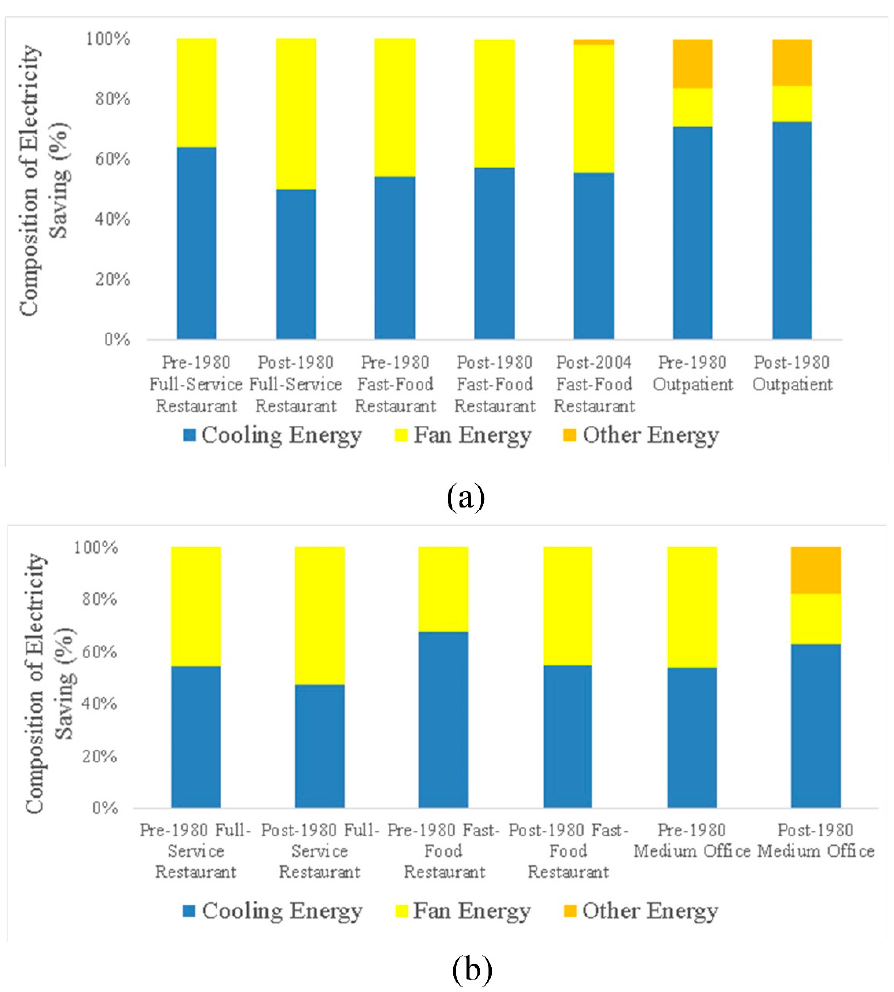
Figure 5. Percentage breakdown (%) of the individual components contributing to the simulated annual electricity savings from green roofs compared with traditional roofs under the A1F1 emission scenario in 2050: ( a ) Glendale; ( b ) Koreatown.